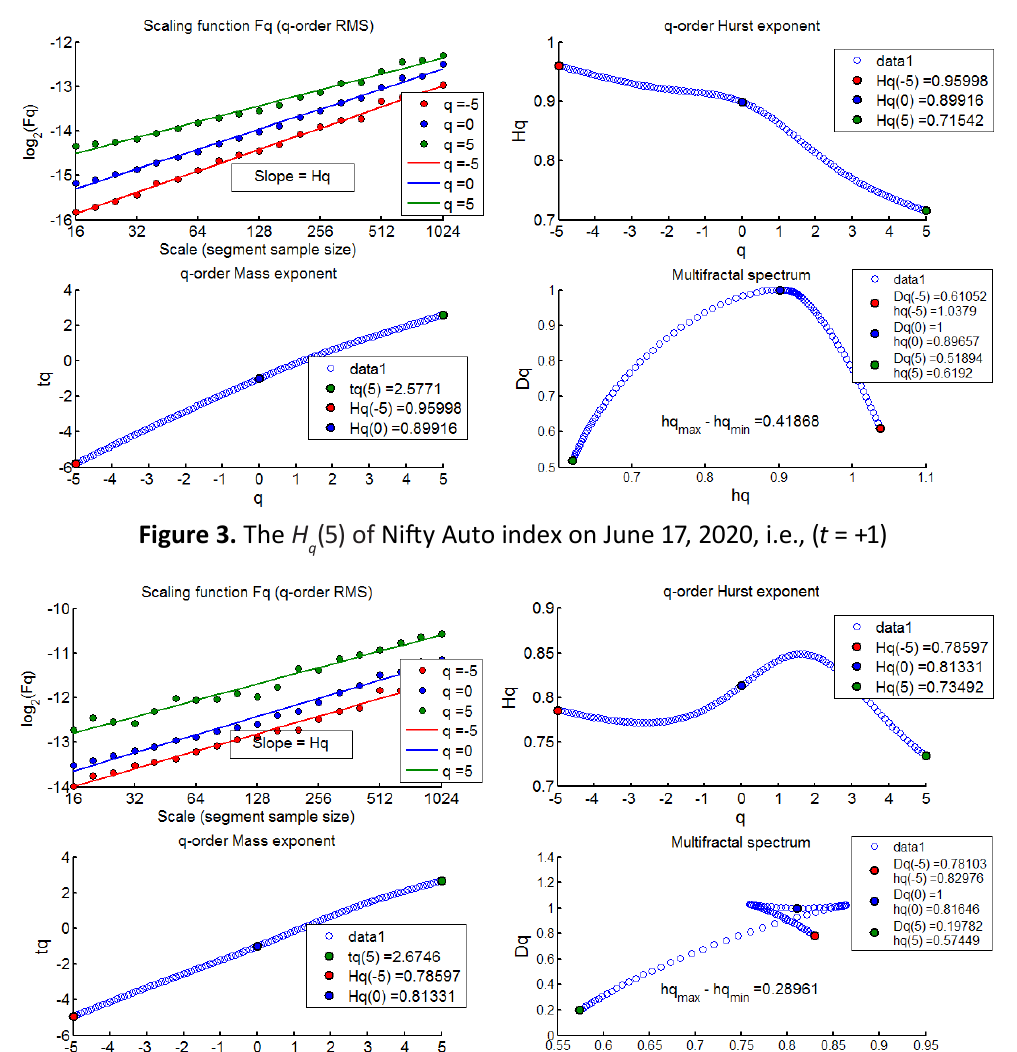
(5) of Nifty Auto index on June 16, 2020, i.e., ( t = 0) Figure 2. The H q